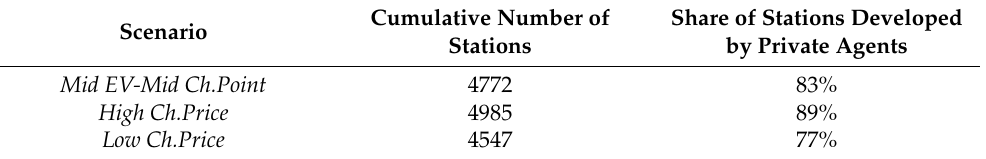
Table 13. Number of charging stations and respective share deployed by the private sector in